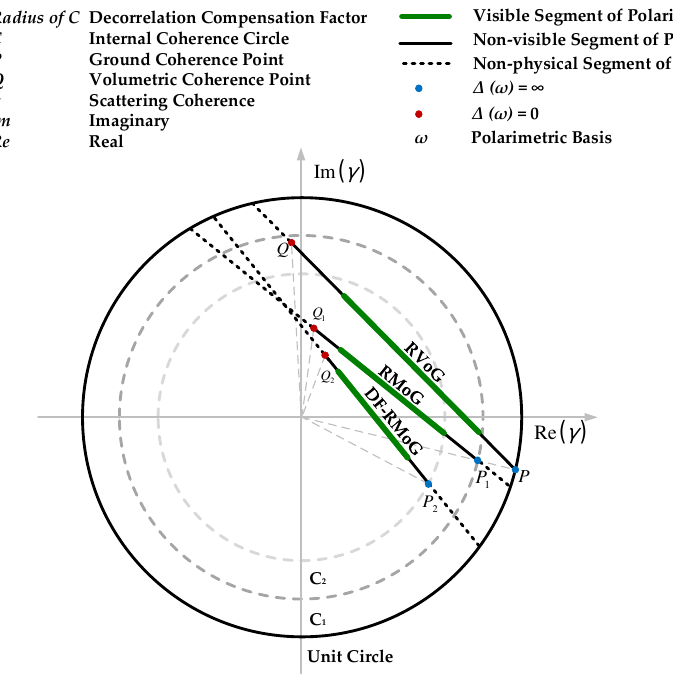
Figure 5. The loci for polarimetric variation of scattering coherences.